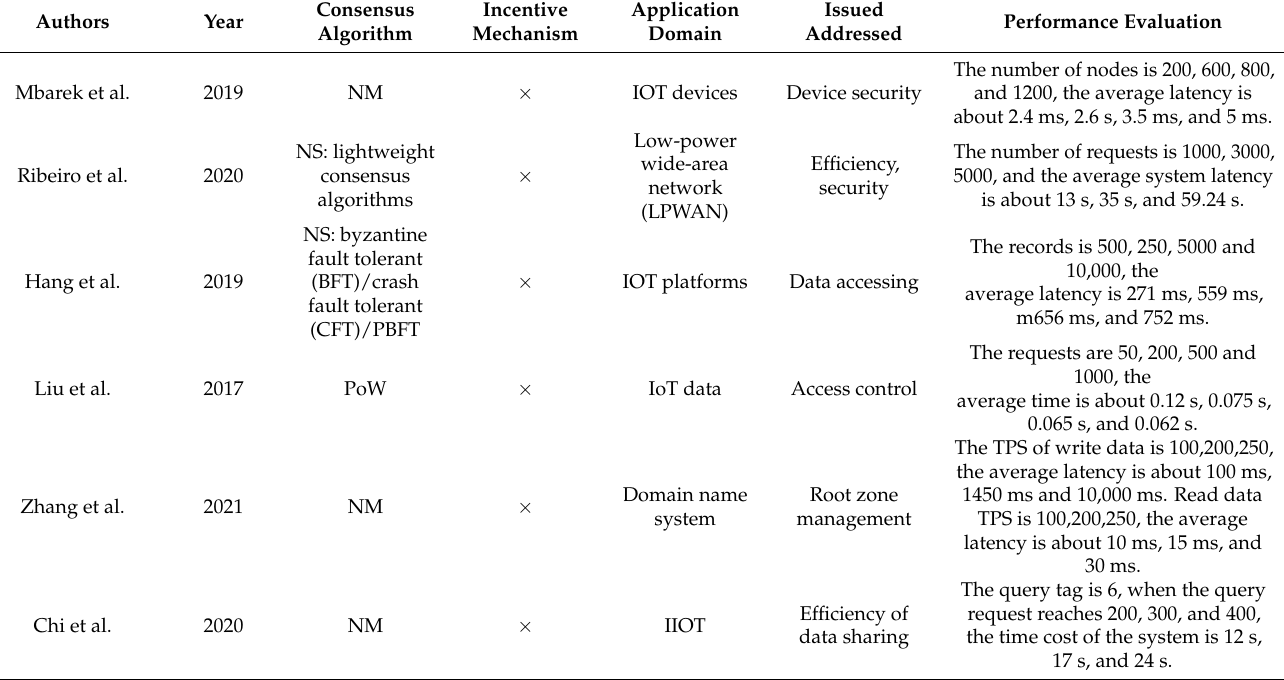
Table 2. Differences between IoT security schemes (continue Table